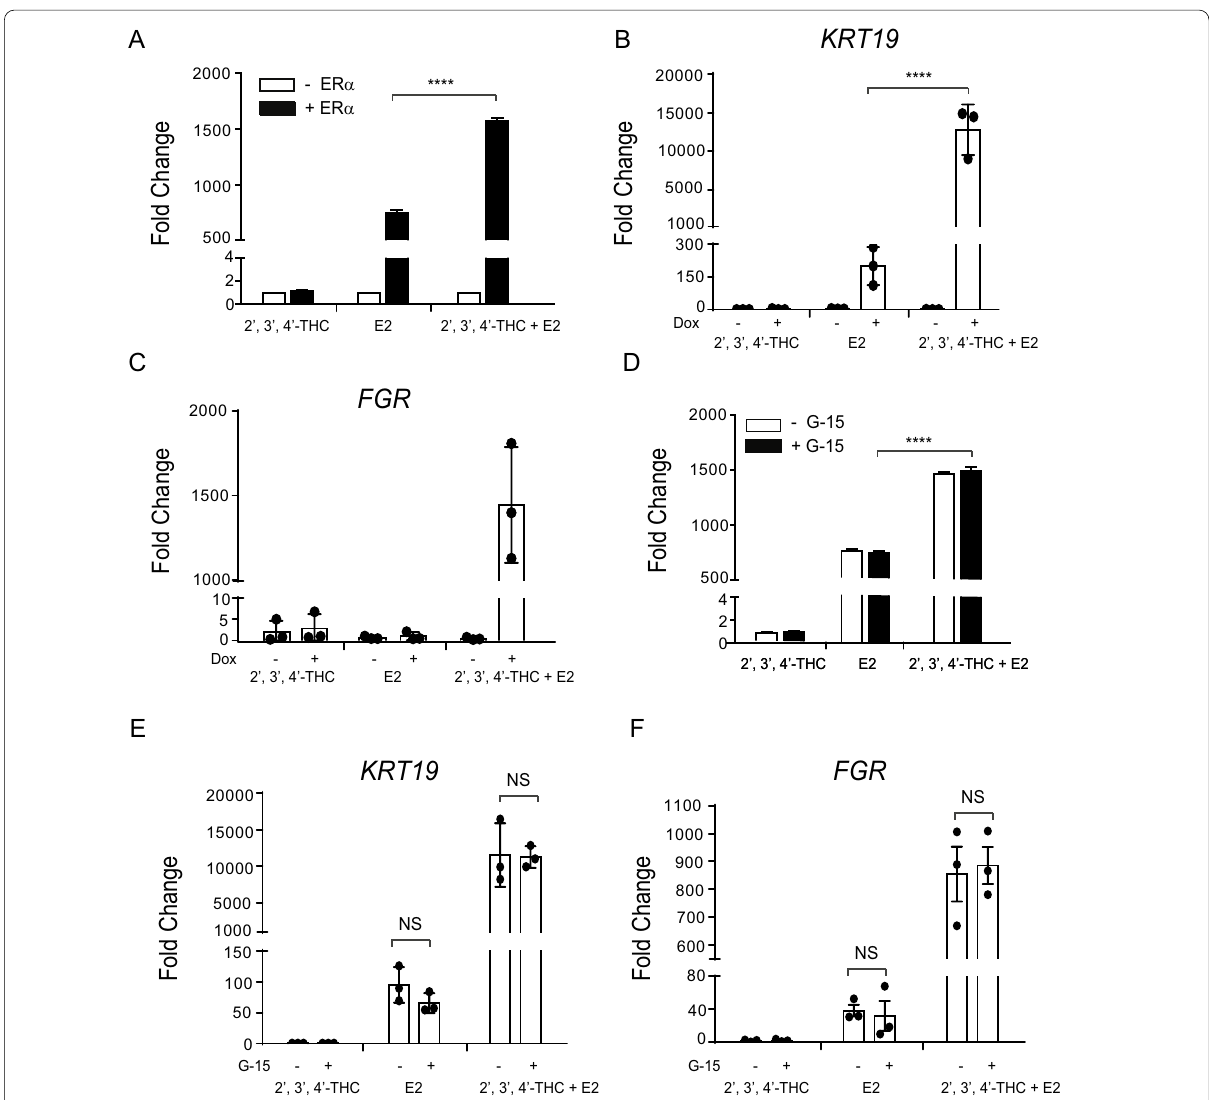
Fig. 4 The effect of E2 and the 2 ′ ,3 ′ ,4 ′ ‑THC/E2 combination on transcription are ERα‑dependent. A U2OS cells were transfected with NKG2E‑TK‑Luc without or with an expression vector for ERα. The cells were treated with 10 nM E2, 5 μM 2 ′ ,3 ′ ,4 ′ ‑THC alone or in combination for 24 h and then luciferase activity was measured. B, C U2OS‑ERα cells were maintained in the absence or presence of 1 µg/ml doxycycline to induce ERα for 24 h and then were treated with 10 nM E2, 5 μM 2 ′ ,3 ′ ,4 ′ ‑THC alone or in combination for 24 h. B KRT19 and C FGR mRNA levels were measured by qRT‑PCR. GAPDH was used as a reference gene to calculate fold change. D The GPER1 antagonist G‑15 had no effect on the activation of NKG2E‑TK‑Luc. U2OS cells were transfected with NKG2E‑TK‑Luc and an expression vector for ERα. The cells were treated with 10 nM E2, 5 μM 2 ′ ,3 ′ ,4 ′ ‑THC alone or in combination for 24 h in the absence and presence of 1 μM G‑15, and then luciferase activity was measured. E, F U2OS‑ERα cells were treated with 10 nM E2, 5 μM 2 ′ ,3 ′ ,4 ′ ‑THC alone or in combination for 24 h in the absence and presence of 1 μM G‑15. E KRT19 and F FGR mRNA levels were measured by qRT‑PCR. The data are mean of triplicate samples SD. The statistical significance was determined by one‑way ± ANOVA followed by Tukey’s multiple comparisons post hoc